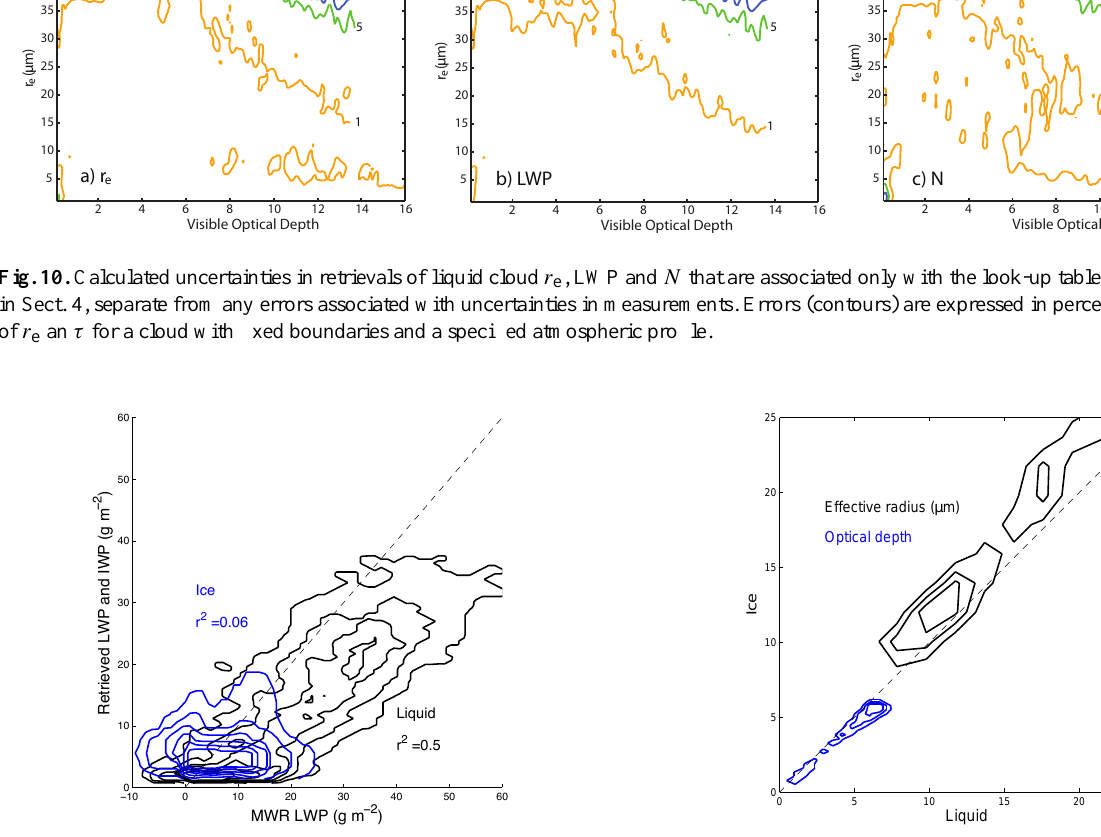
Fig. 12. Linear probability density distributions (contours) for re- trieved clouds of “uncertain” phase depending on whether the re- fractive indices in the retrievals are assumed to be those of ice or liquid. The dashed line is a 1:1